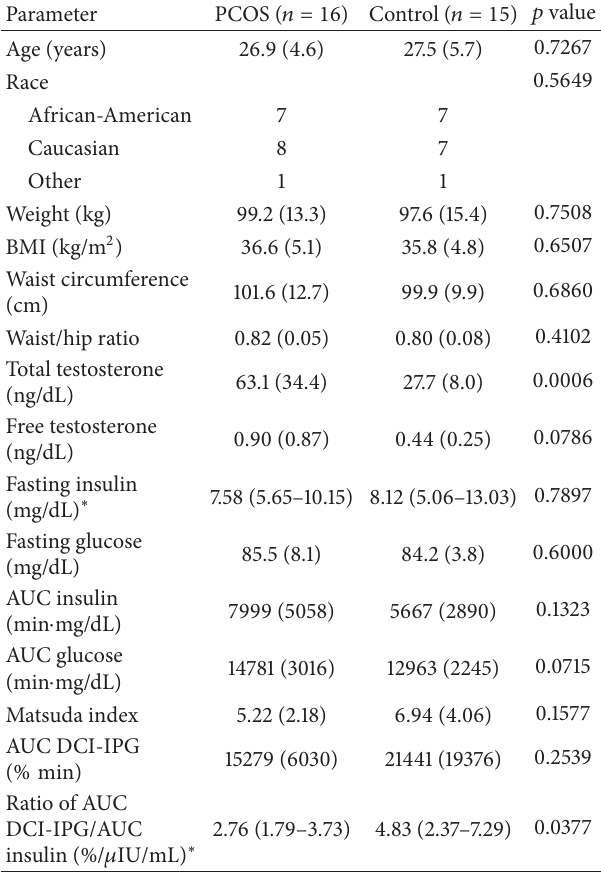
Table 1: Baseline characteristics and serum hormone concentra-